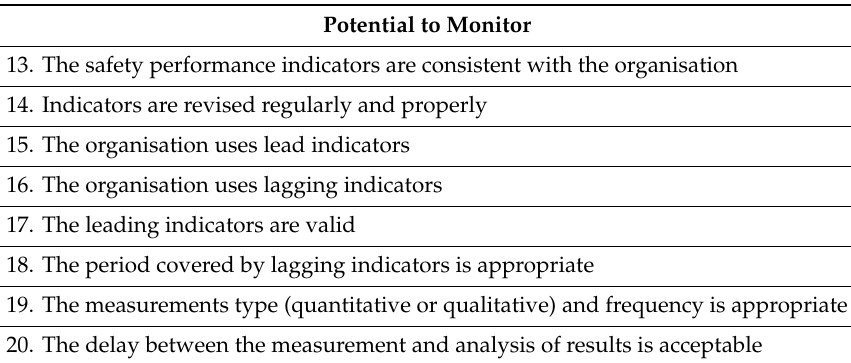
Table 3. Potential to Monitor survey